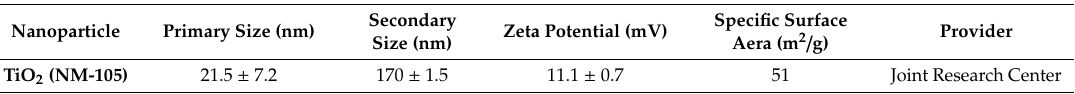
Table 1. TiO 2 NP